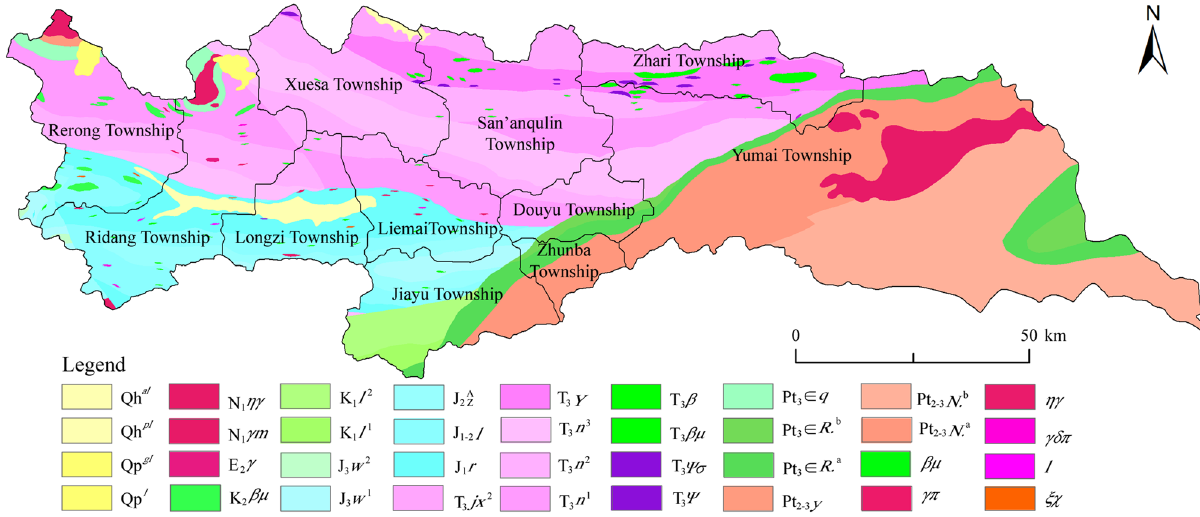
Figure 7. The geological map of the Longzi County (the strata distribution was cited from Digital Library of National Geological Archives of China, URL: http:// www. ngac. org. cn; this figure was created with ArcGIS 10.8, URL: https:// www. esri. com/ en- us/ arcgis/ produ cts/